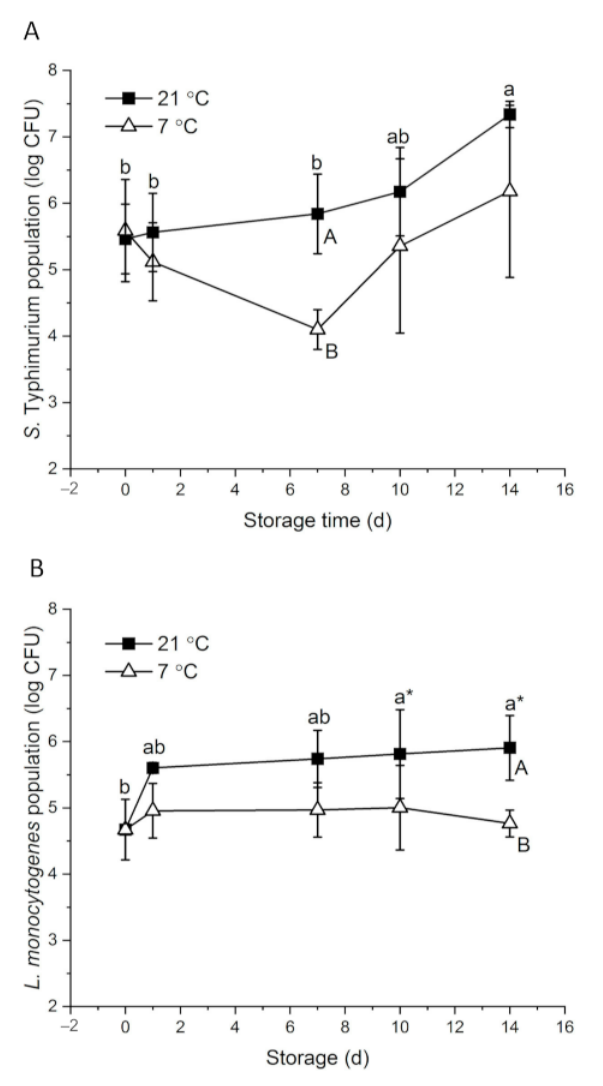
Figure 1. Behavior of S. Typhimurium ( A ) and L. monocytogenes ( B ) on whole papayas at 21 and 7 ◦ C. Error bars are standard deviations ( n = 3). Different lower-case letters horizontally indicate significant differences between the means of different time points at each temperature ( p < 0.05). Different upper-case letters vertically indicate significant differences ( p < 0.05) between the means of different temperatures at the same time point. “a*” means p values were marginal, which were 0.058 and 0.059 on day 10 and day 14, respectively, compared with day